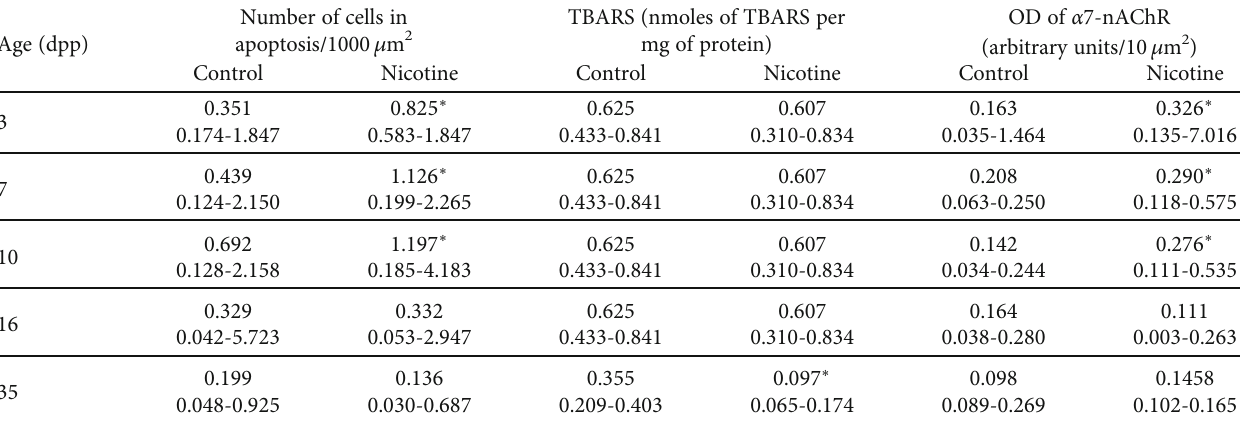
Table 3: Evaluated parameters (median and interquartile ranges) in control and nicotine-exposed animals. Age (dpp)